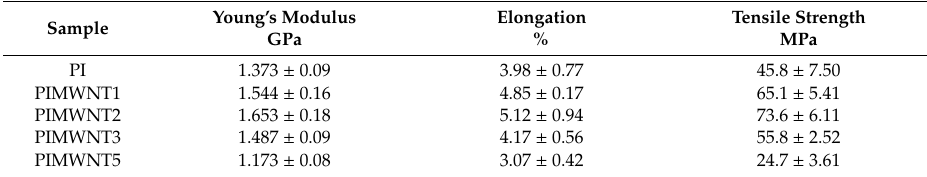
Table 3. Young’s modules, elongation, and tensile strength measurements of the five polyimide based studied membranes.